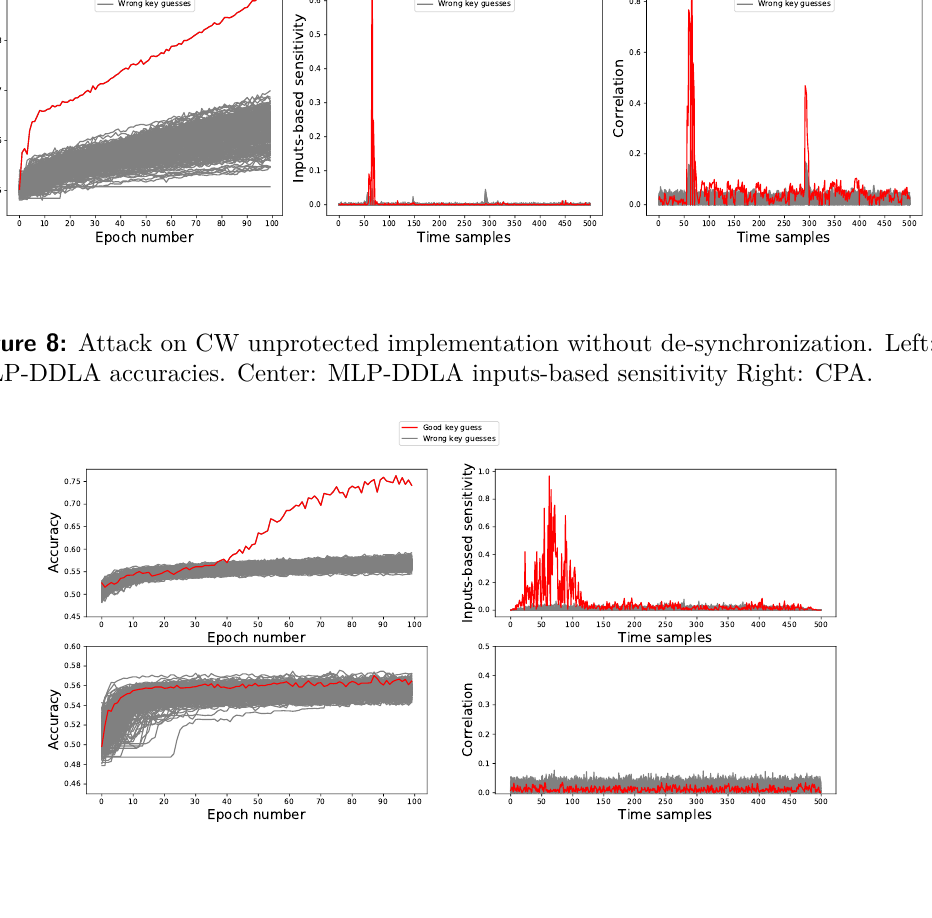
Figure 9: Attack on CW unprotected implementation with de-synchronization. Top-left: CNN-DDLA accuracies. Top-right: CNN-DDLA inputs-based sensitivity. Bottom-left: MLP-DDLA accuracies. Bottom-right: